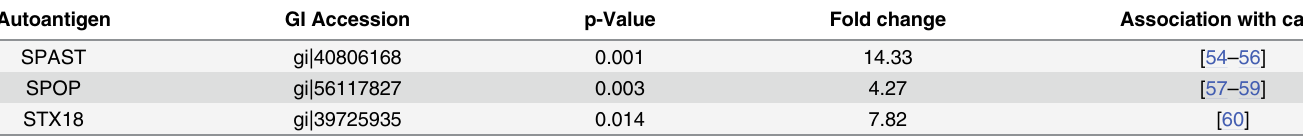
Table 3. Candidate autoantigens selected for analysis of their tissue expression pattern.